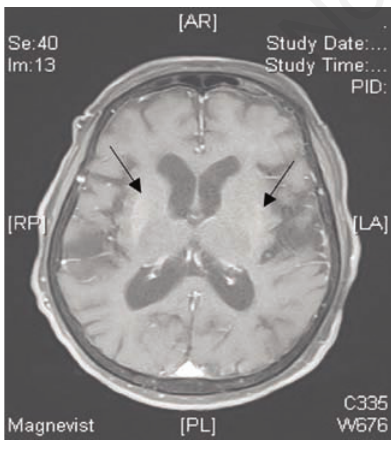
Figure 1. Gadolinium-enhanced brain magnetic resonance imaging shows hyper- intensity signal over bilateral putamen regions in T1 weighted